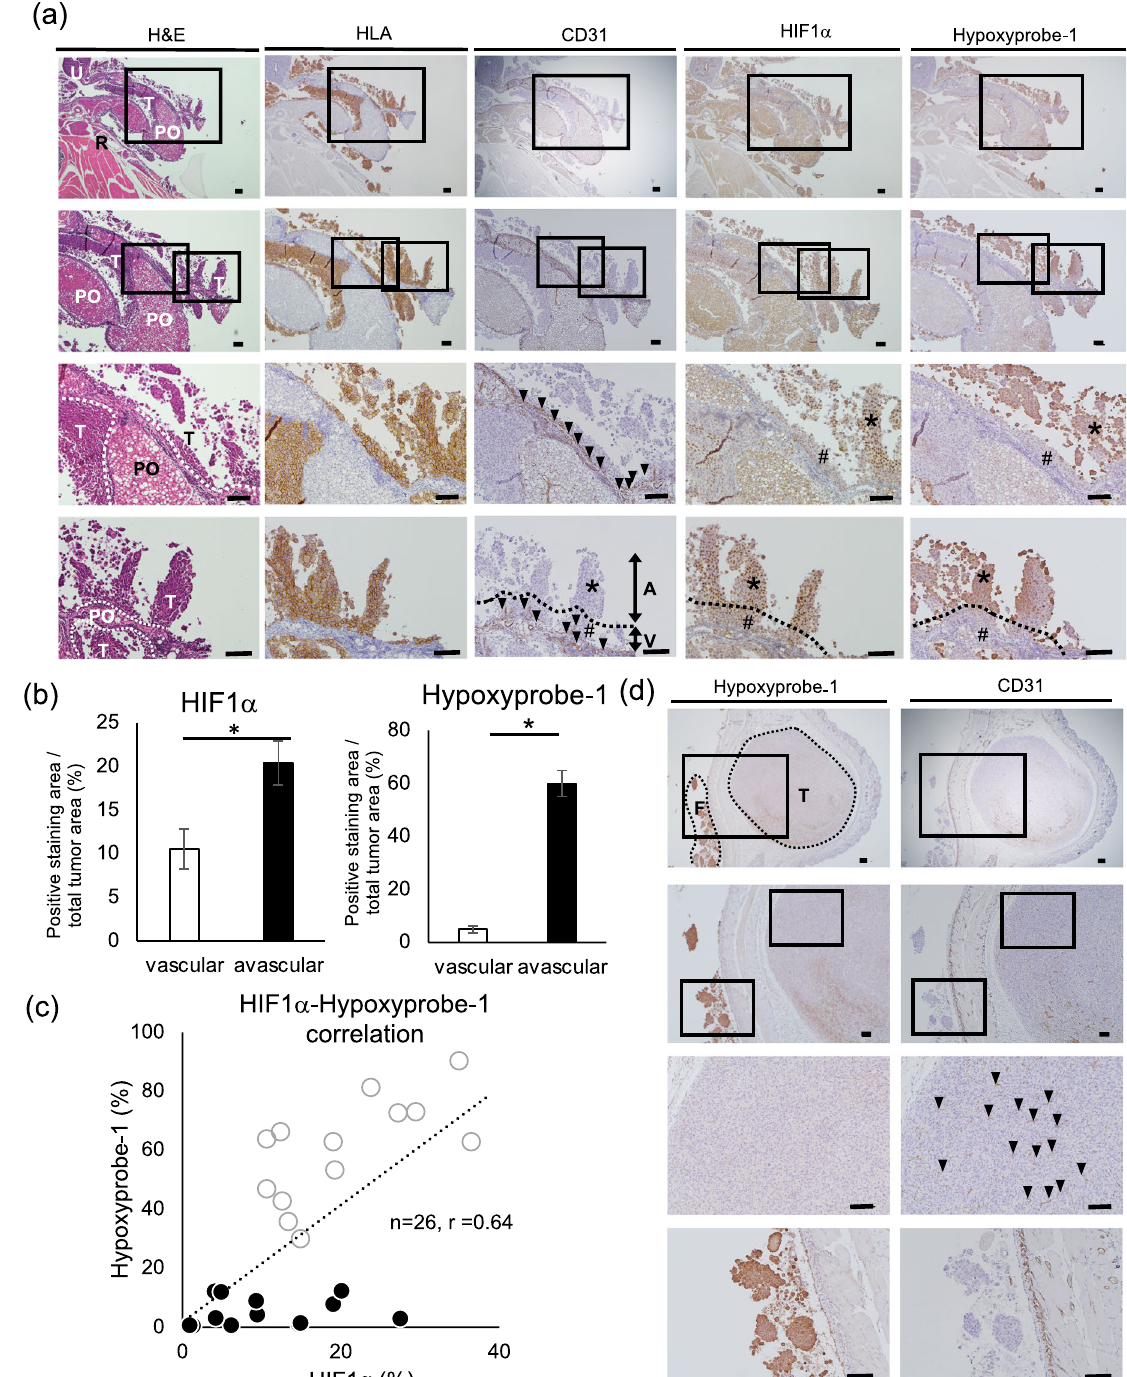
Figure 3. Expression analysis of hypoxia-related proteins in ES-2-disseminated cancer using our method. ( a ) Images of hematoxylin and eosin (H&E)-, HLA-, CD31-, HIF1α-, and hypoxyprobe-1-stained tissue. “*” and “A” indicates an avascular cancer region; “#” and “V” indicates a vascular cancer region; arrowheads indicate CD31-positive blood vessels. The dotted line indicates the border between vascular and avascular region. T disseminated cancer, U uterus, R retroperitoneal adipose tissue, PO periovarian adipose tissue. Scale bars: 100 µm. ( b ) Statistical analysis of HIF1α- and hypoxyprobe-1-stained tumor areas in the vascular regions (i.e., tumor areas within 100 µm of CD31-positive vessels) and avascular regions (i.e., tumor areas 100 µm away from CD31-positive vessels); n = 26. An unpaired t -test was performed for statistical analysis. *P < 0.05. ( c ) Correlation coefficient between HIF1α and hypoxyprobe-1; n = 26; R = 0.64. ( d ) hypoxyprobe-1 (left) and CD31 (right) staining for peritoneal and subcutaneous cancer tissue. The arrowheads indicate CD31-positive blood vessels. T disseminated cancer, F cancer cells floating in ascitic fluid. Scale bars: 100